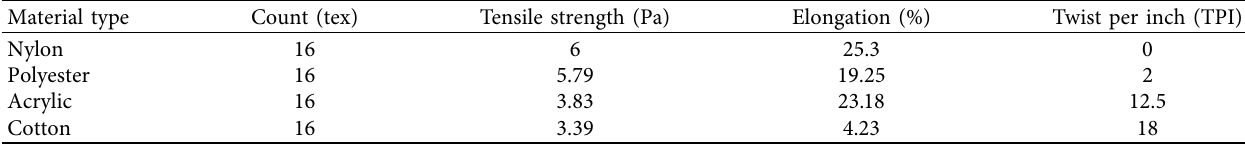
Table 5: Mechanical properties of the yarn.